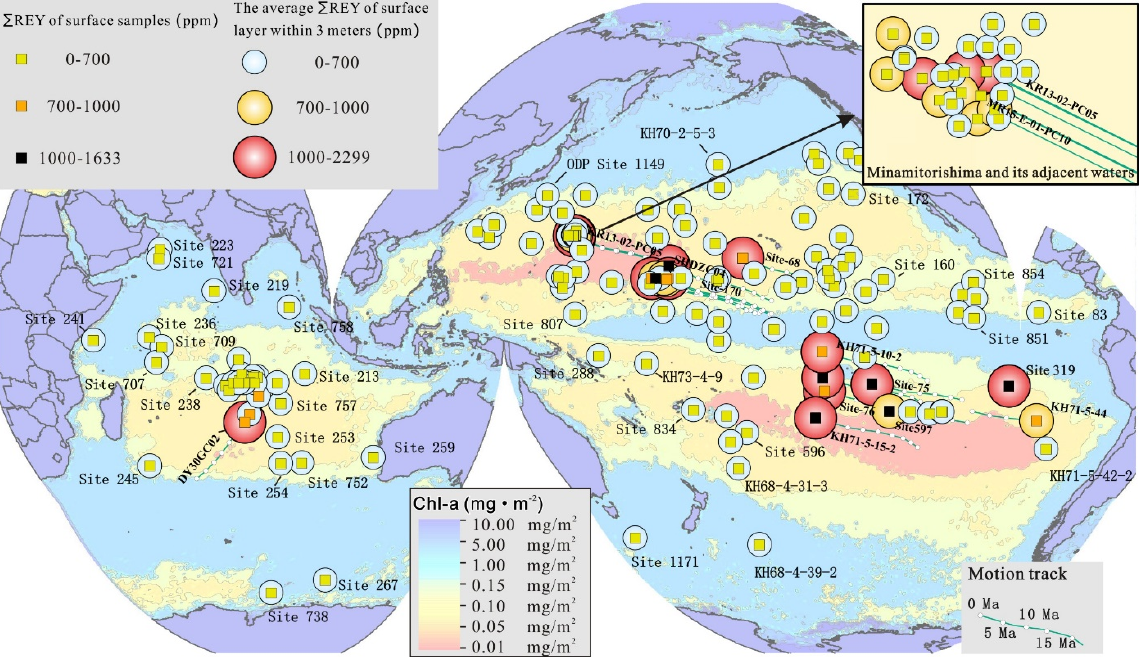
Figure 1. Contents of REY ( Σ REY) in surface and surface layer within 3 m samples of deep ‐ sea sediments from the Pacific and Indian oceans. Data are from [1,3,4,6–8,10–15]. The motion track is 5 Ma/point, and the data are from [16]. The data of Chl ‐ a (chlorophyll content) in surface seawater are from [17].